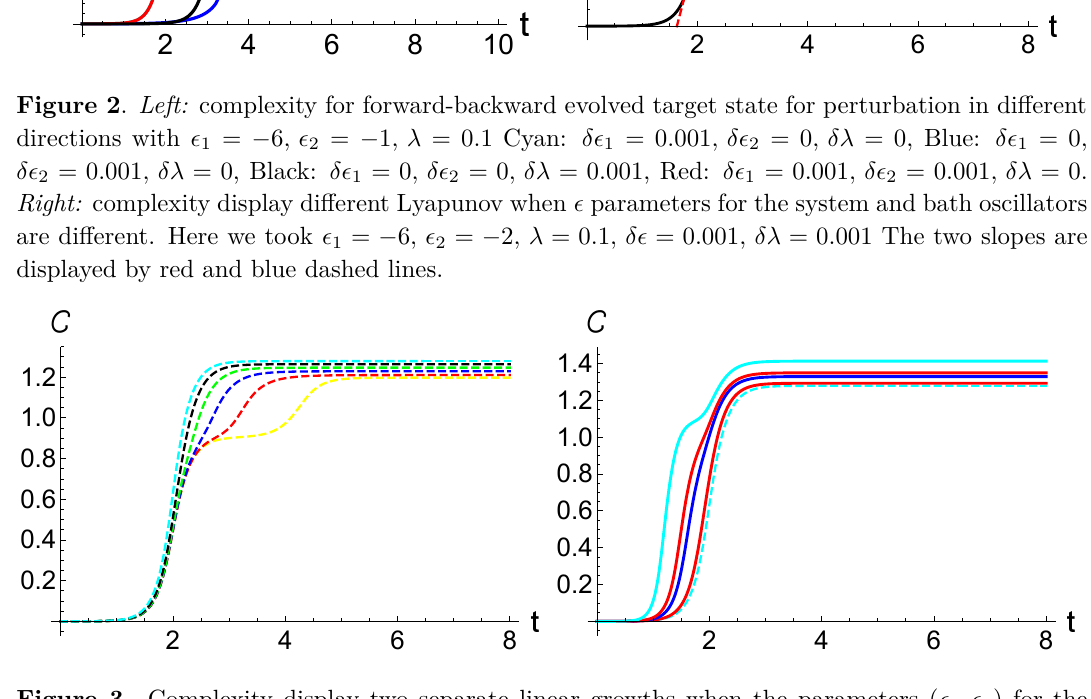
is fixed at -6 2